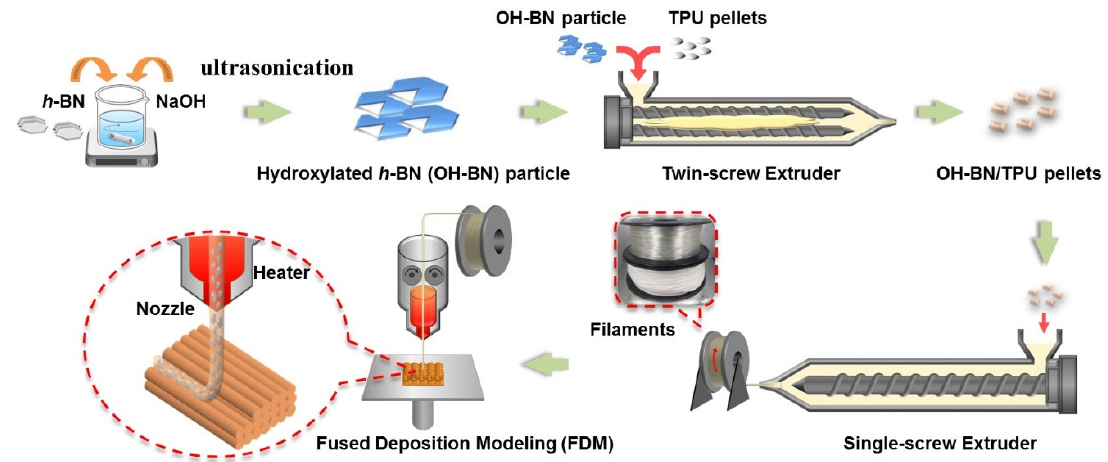
Figure 1. Schematic of the full preparation procedure of the OH-BN/TPU and h-BN/TPU filaments and their 3D-printed composites.